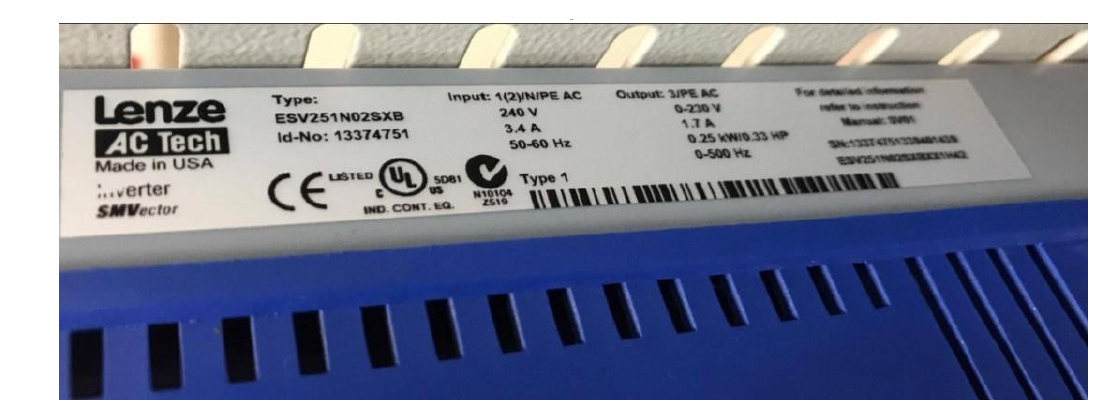
FIG. 26. RATINGS OF CONTROLLER